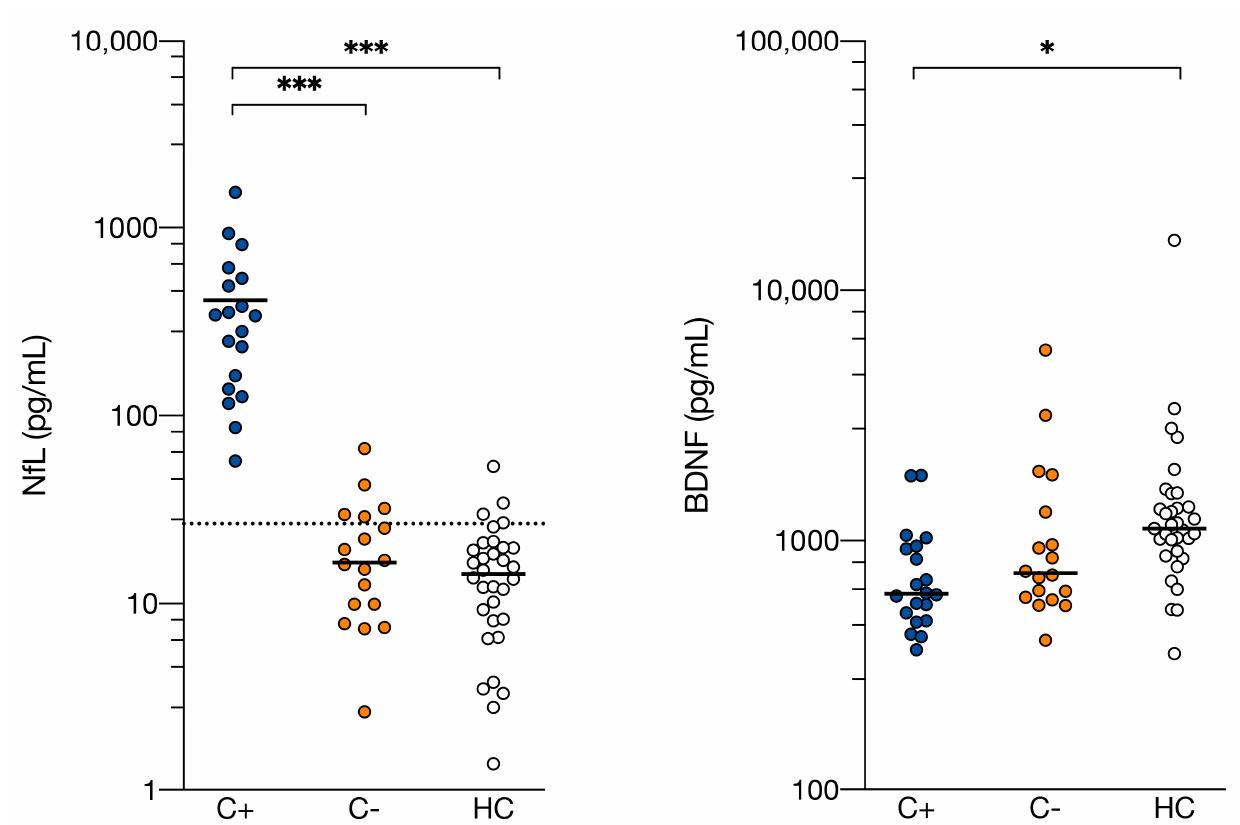
Figure 3. Serum neurofilament light chain and plasma brain-derived neurotrophic factor levels are altered after chemotherapy treatment. Neurofilament light chain (NfL) and brain derived-neurotrophic factor (BDNF) levels were mea- sured in serum and plasma, respectively, of 19 C+ (breast cancer patients treated with chemotherapy), 18 C − (chemotherapy- naïve breast cancer patients) and 33 HC (healthy women) and showed to be altered in C+ compared to both control groups for NfL and only compared to HC for BDNF. Individual values with group medians are presented. The dotted line indicates diagnostic cutoff level for neurodegenerative disease with NfL immunoassay serum measurement. Group differences were assessed with ANOVA analysis with group as factor and age as covariate, with post-hoc least significance difference tests to assess which groups differ. *** p < 0.001, * p <